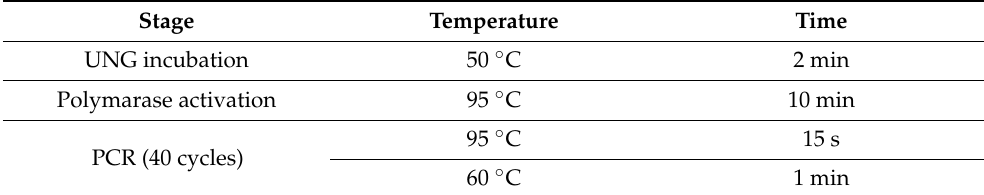
Table 1. Thermal protocol used for TaqMan RT-PCR